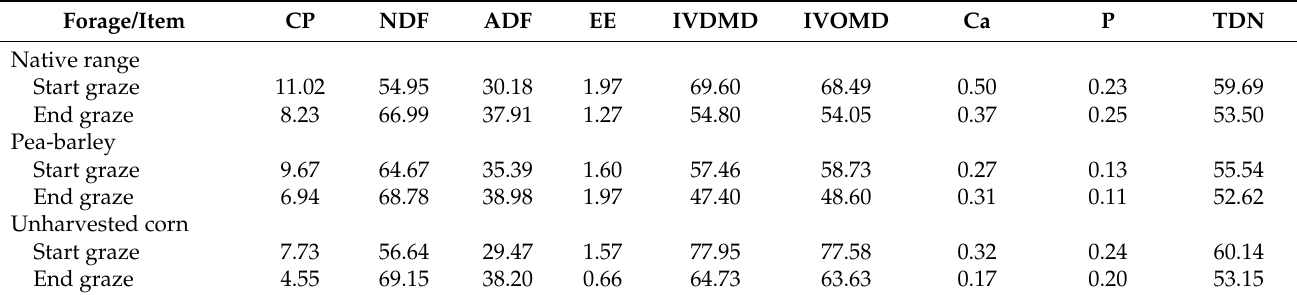
Table 2. Native range and annual forage start and end grazing nutrient analysis (DM).